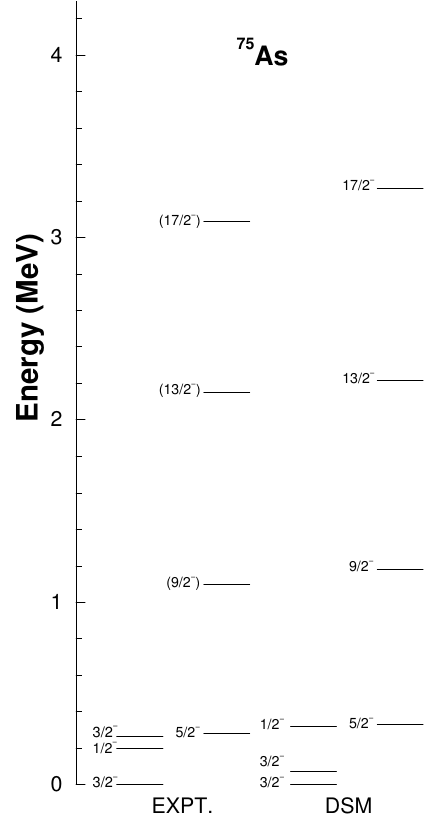
Figure 2. Comparison of Deformed Shell Model (DSM) results with experimental data for 75 As for collective bands with negative parity. The experimental values are taken from